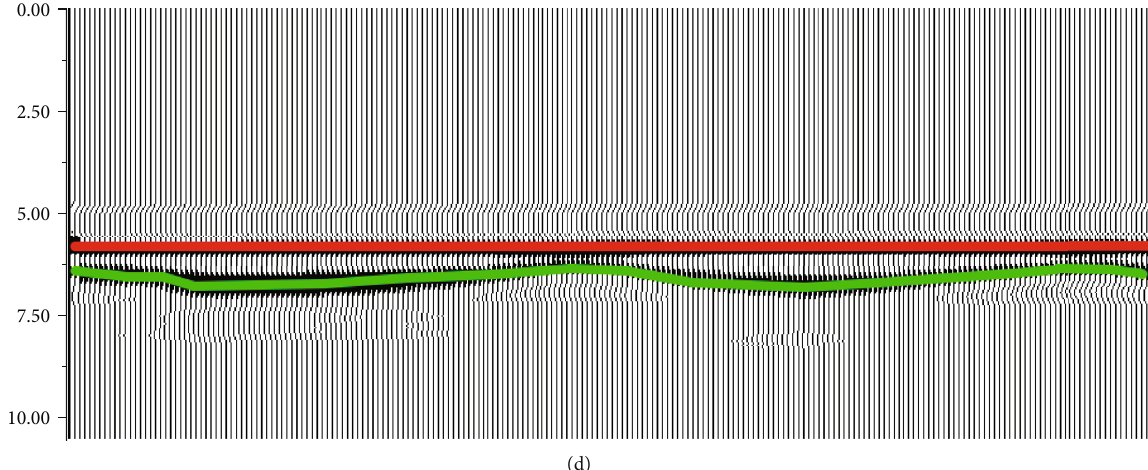
Figure 9: Geological radar map of segment detection. (a) Left side of the fourth pipe. (b) Right side of the fourth pipe. (c) Left side of the fi fth pipe. (d) Right side of the fi fth pipe.